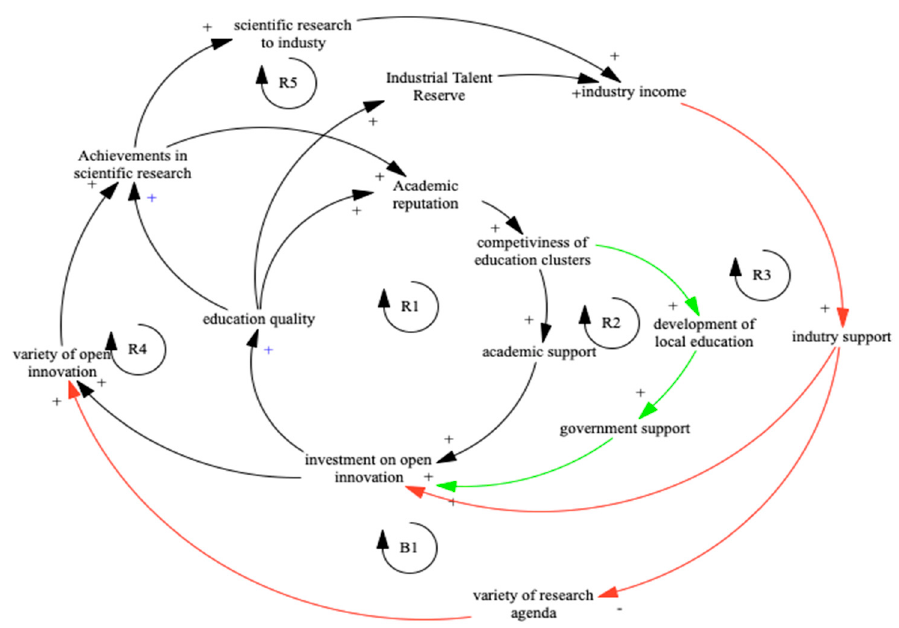
Figure 4. A casual loop diagram for the open innovation ecosystem in higher education; Note: The causal link points from cause to effect, while positive link (+) means change in same direction and negative link (-) means the opposite. Loop label R represents reinforcing loop that exaggerates what happens, and label B represents balancing loop that fill the gap existed.